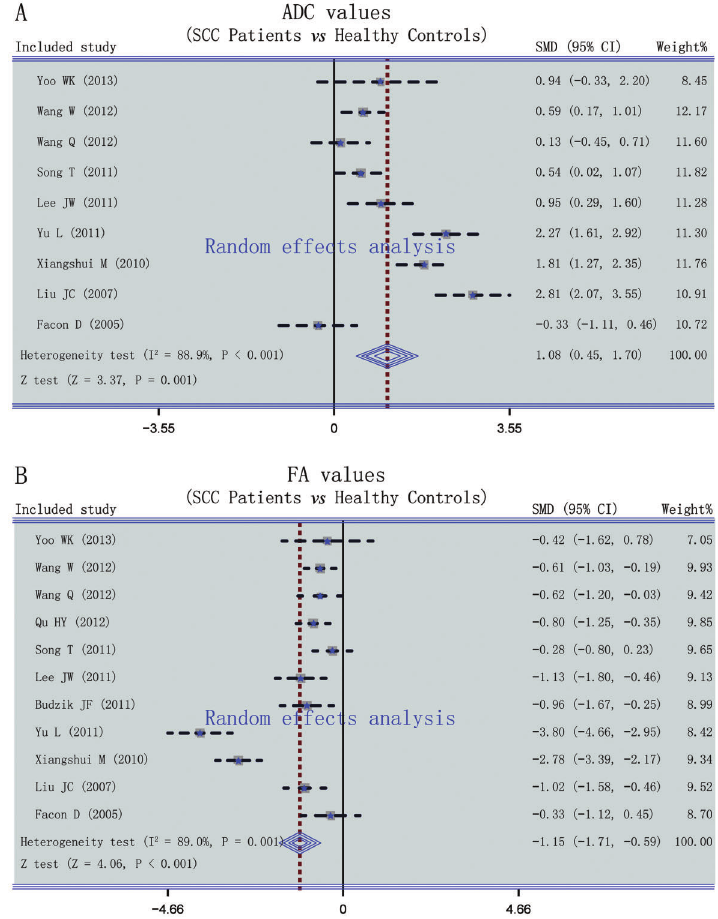
Figure 2. Forest plots of the difference in the frequency of the apparent diffusion coef fi cient (ADC) and fractional anisotropy (FA) values between patients with spinal cord compression (SCC) and healthy subjects ( A , ADC; B , FA value). See Figure 1 for reference details. SMD: standard mean